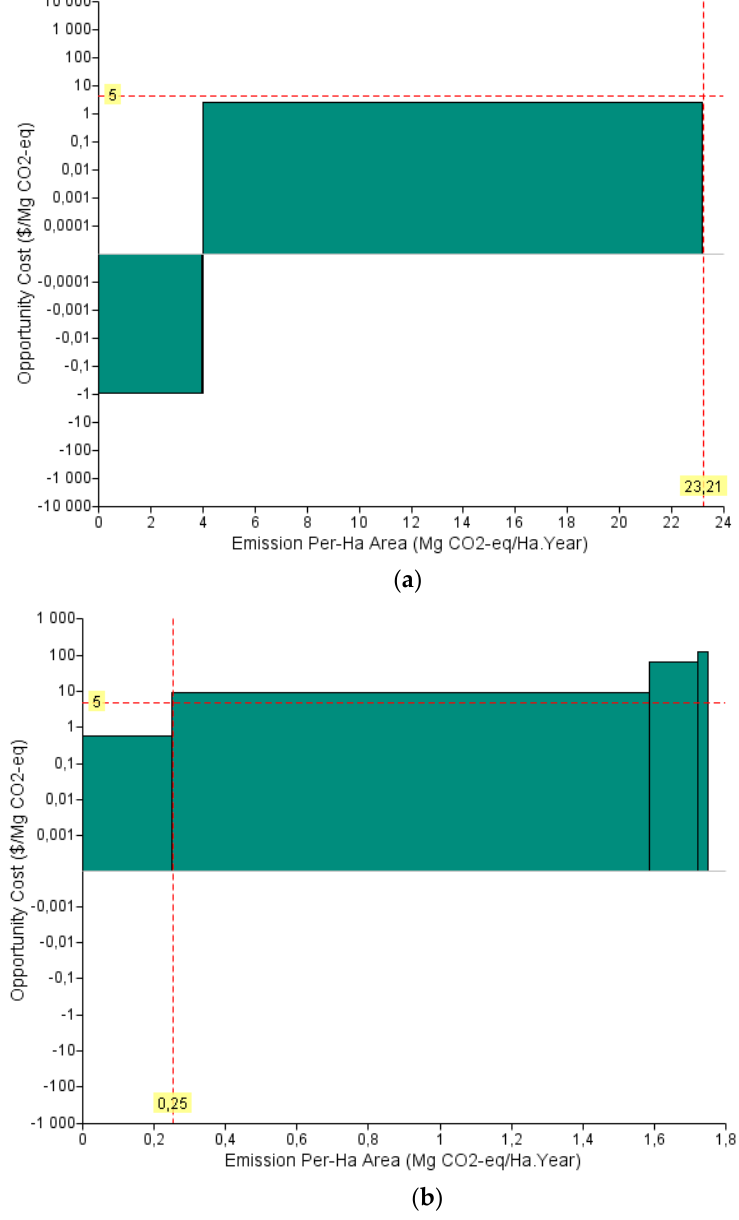
Figure 5 : Abatement cost curves 2000–2012 processed with the REDD Abacus [27]: (a) Samsoom Figure 5. Abatement cost curves 2000–2012 processed with the REDD Abacus [27]: ( a ) Samsoom village, Laos; (b) Diem village, Vietnam. village, Laos; ( b ) Diem village,